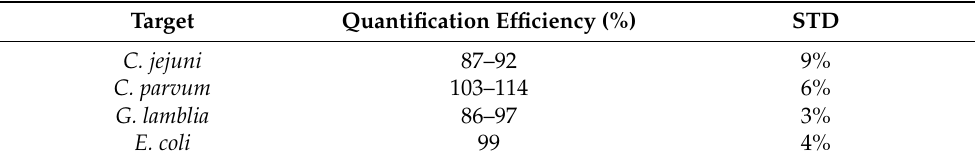
Table 6. Quantification efficiency (QE) of individual pathogens in a 100 mL mix-pathogen tap water sample treated with 20% phosphoric acid and rinsed with 3 mL of MilliQ-H 2 O. QE% values exceeding 100% likely due to Cp fluctuations in